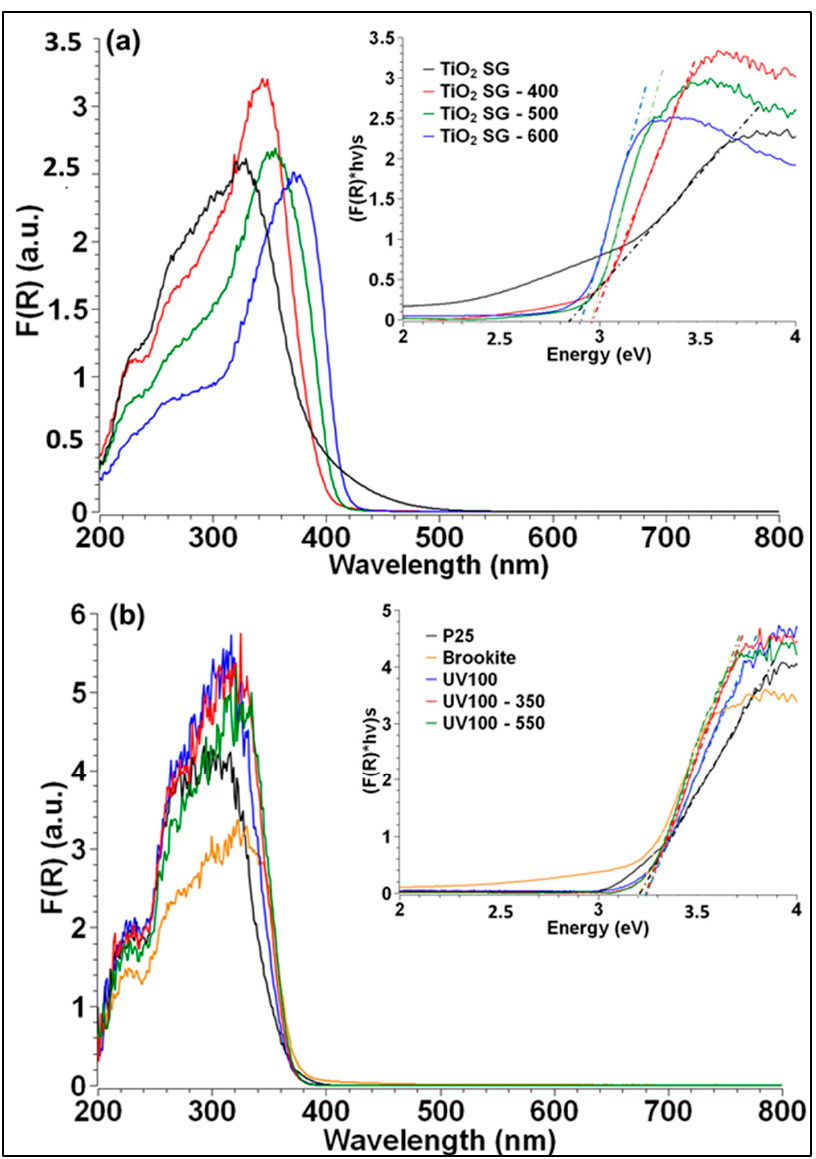
Figure 3. Kubelka–Munk function F(R) of ( a ) TiO 2 SG – X and ( b ) TiO 2 P25, TiO 2 Brookite, and TiO 2 UV-100 – X commercial-based samples, ( Insert ) Tauc plots.